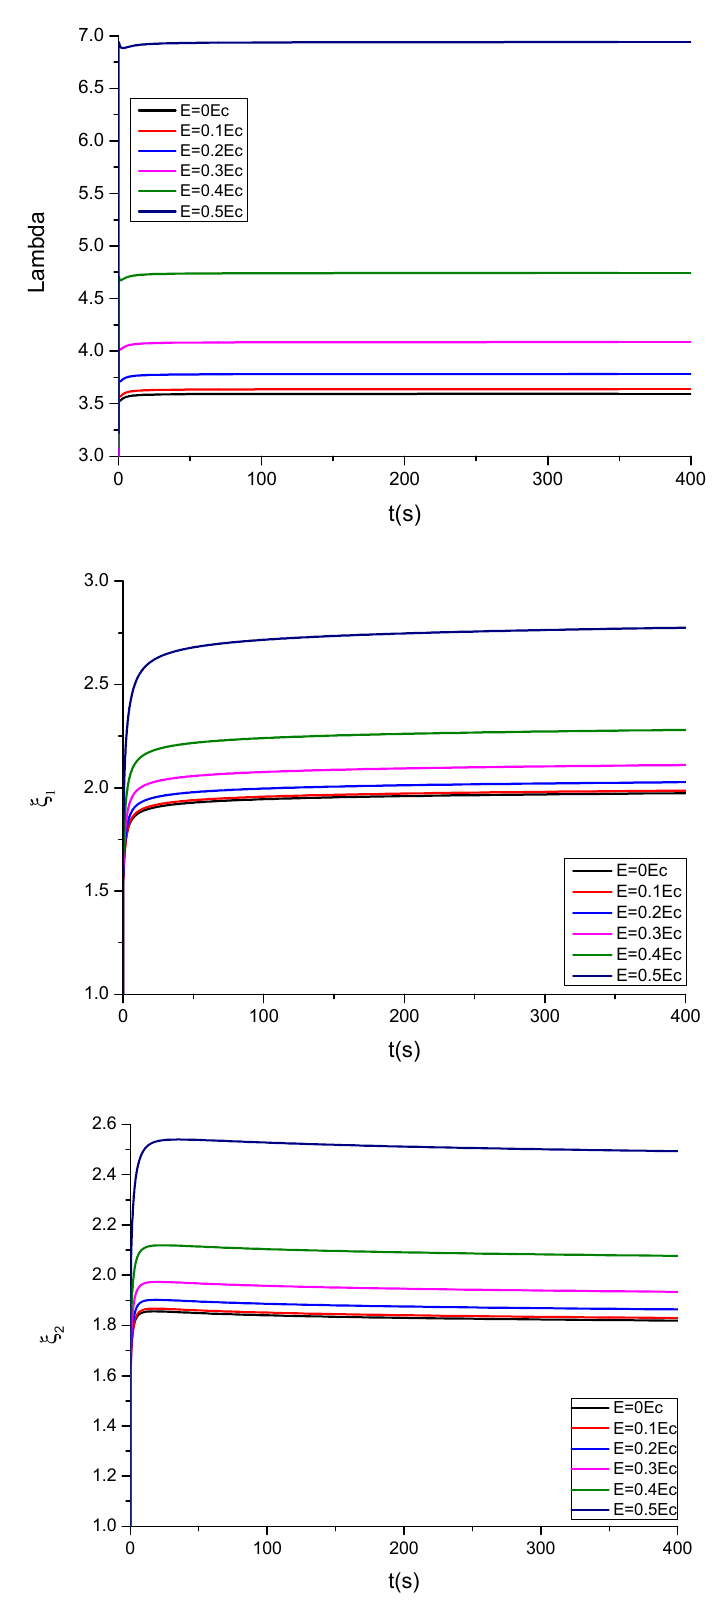
Figure 9. Plot of the bifurcation values of λ , ξ 1 , ξ 2 as a function of time for different values of the electric field E, for the case of a material with an energy function given by Equation (18a) (compliant electrodes).